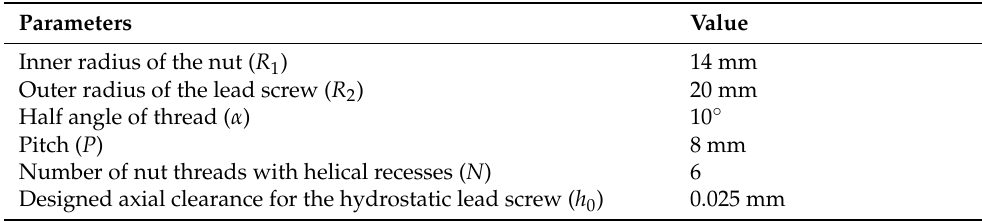
Table 2. Parameters of the hydrostatic lead